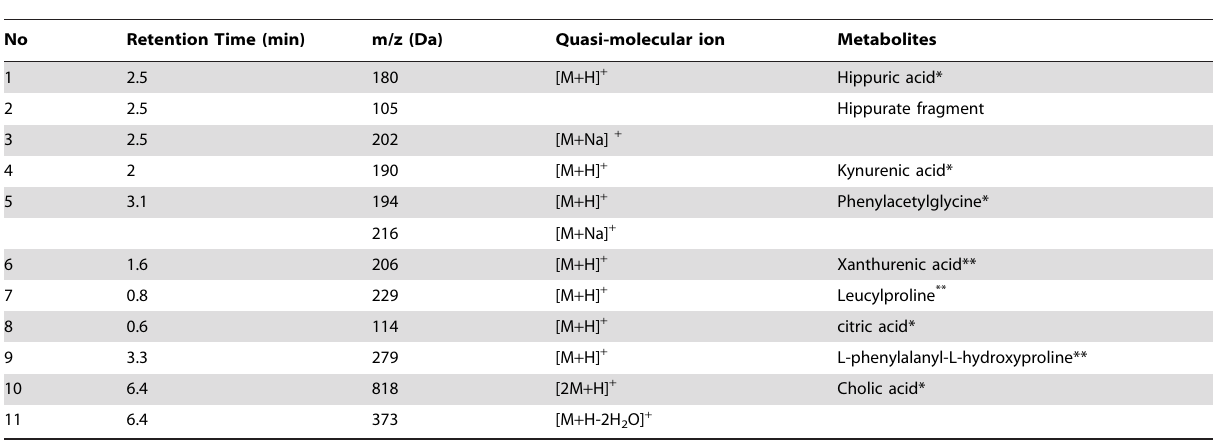
Table 2. Biomarkers of hepatotoxicity induced by GF